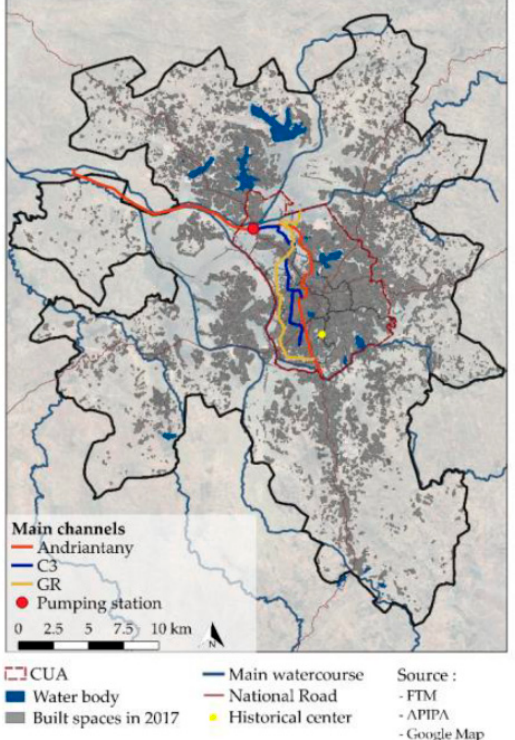
Figure 4. Agglomeration’s main drainage system.